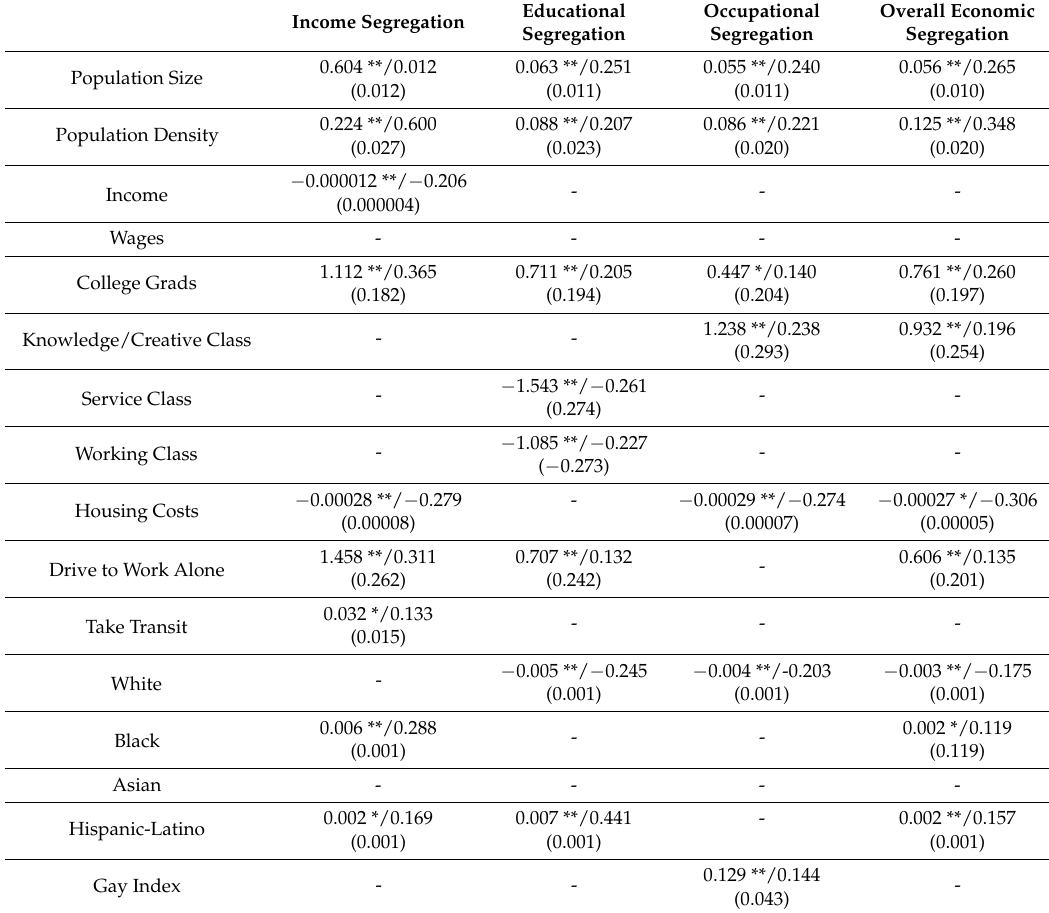
Table 4. Regression Analysis